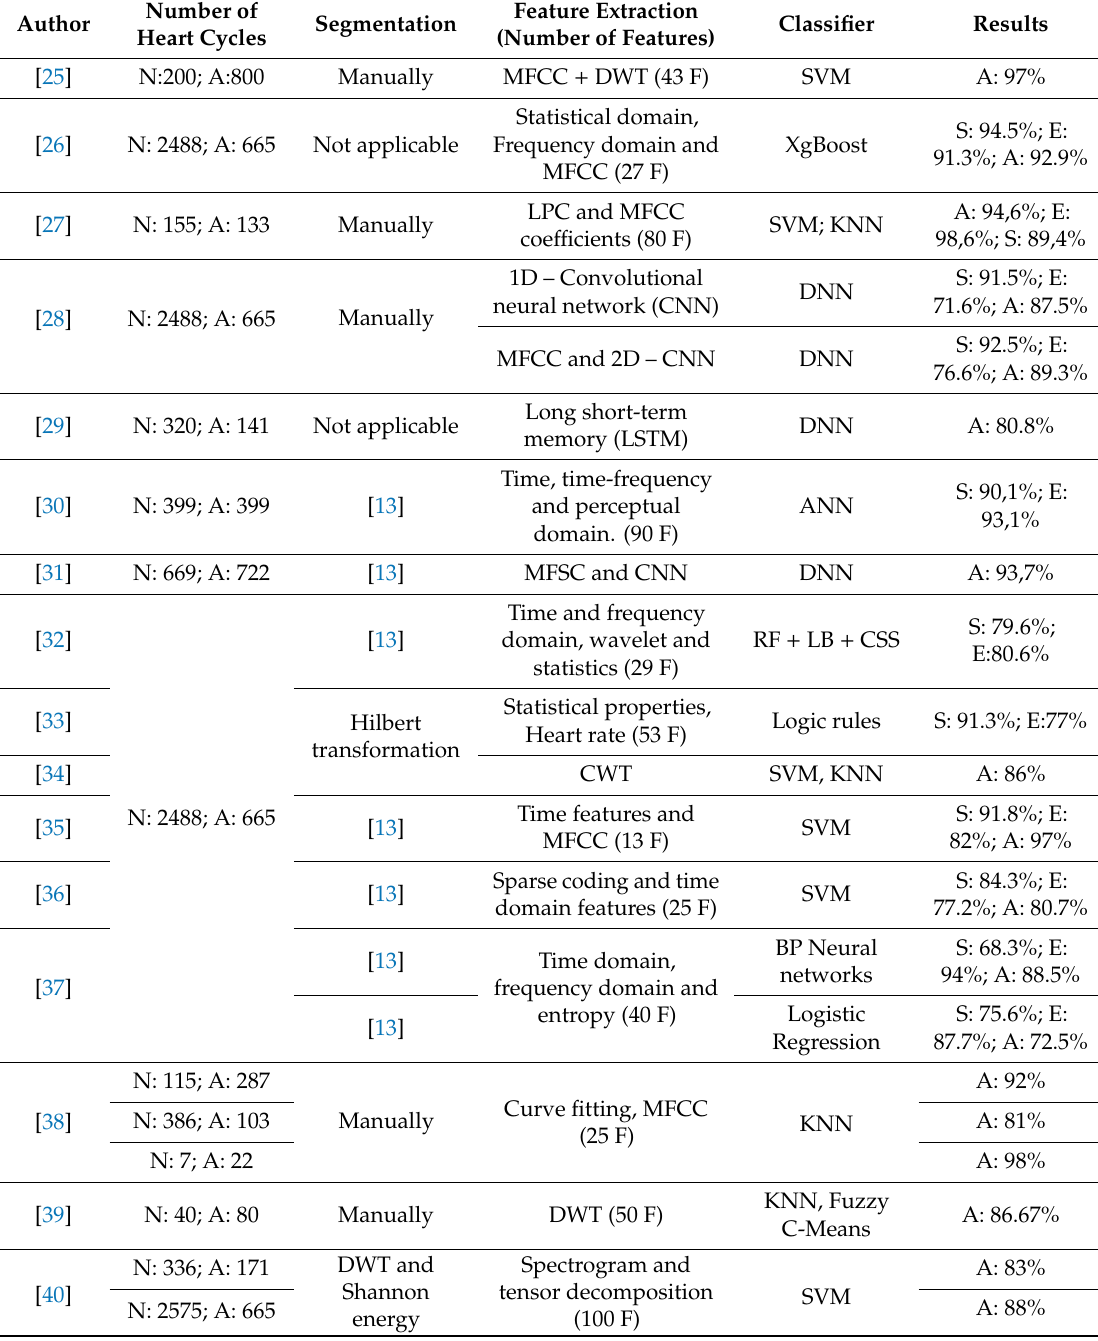
Table 2. Summary of the state-of-the-art approaches. N: normal, A: abnormal, T: total, NN: does not specify the data, F: features, A: accuracy, E: specificity, S: sensibility, DWT: discrete wavelet transform, LPC: linear prediction coe ffi cients, SVM: support vector machine, KNN: K-nearest neighbor, RF: random forest, LB: LogitBoost, CSS: cost-sensitive classification, DNN: dense neural network, ANN: artificial neural